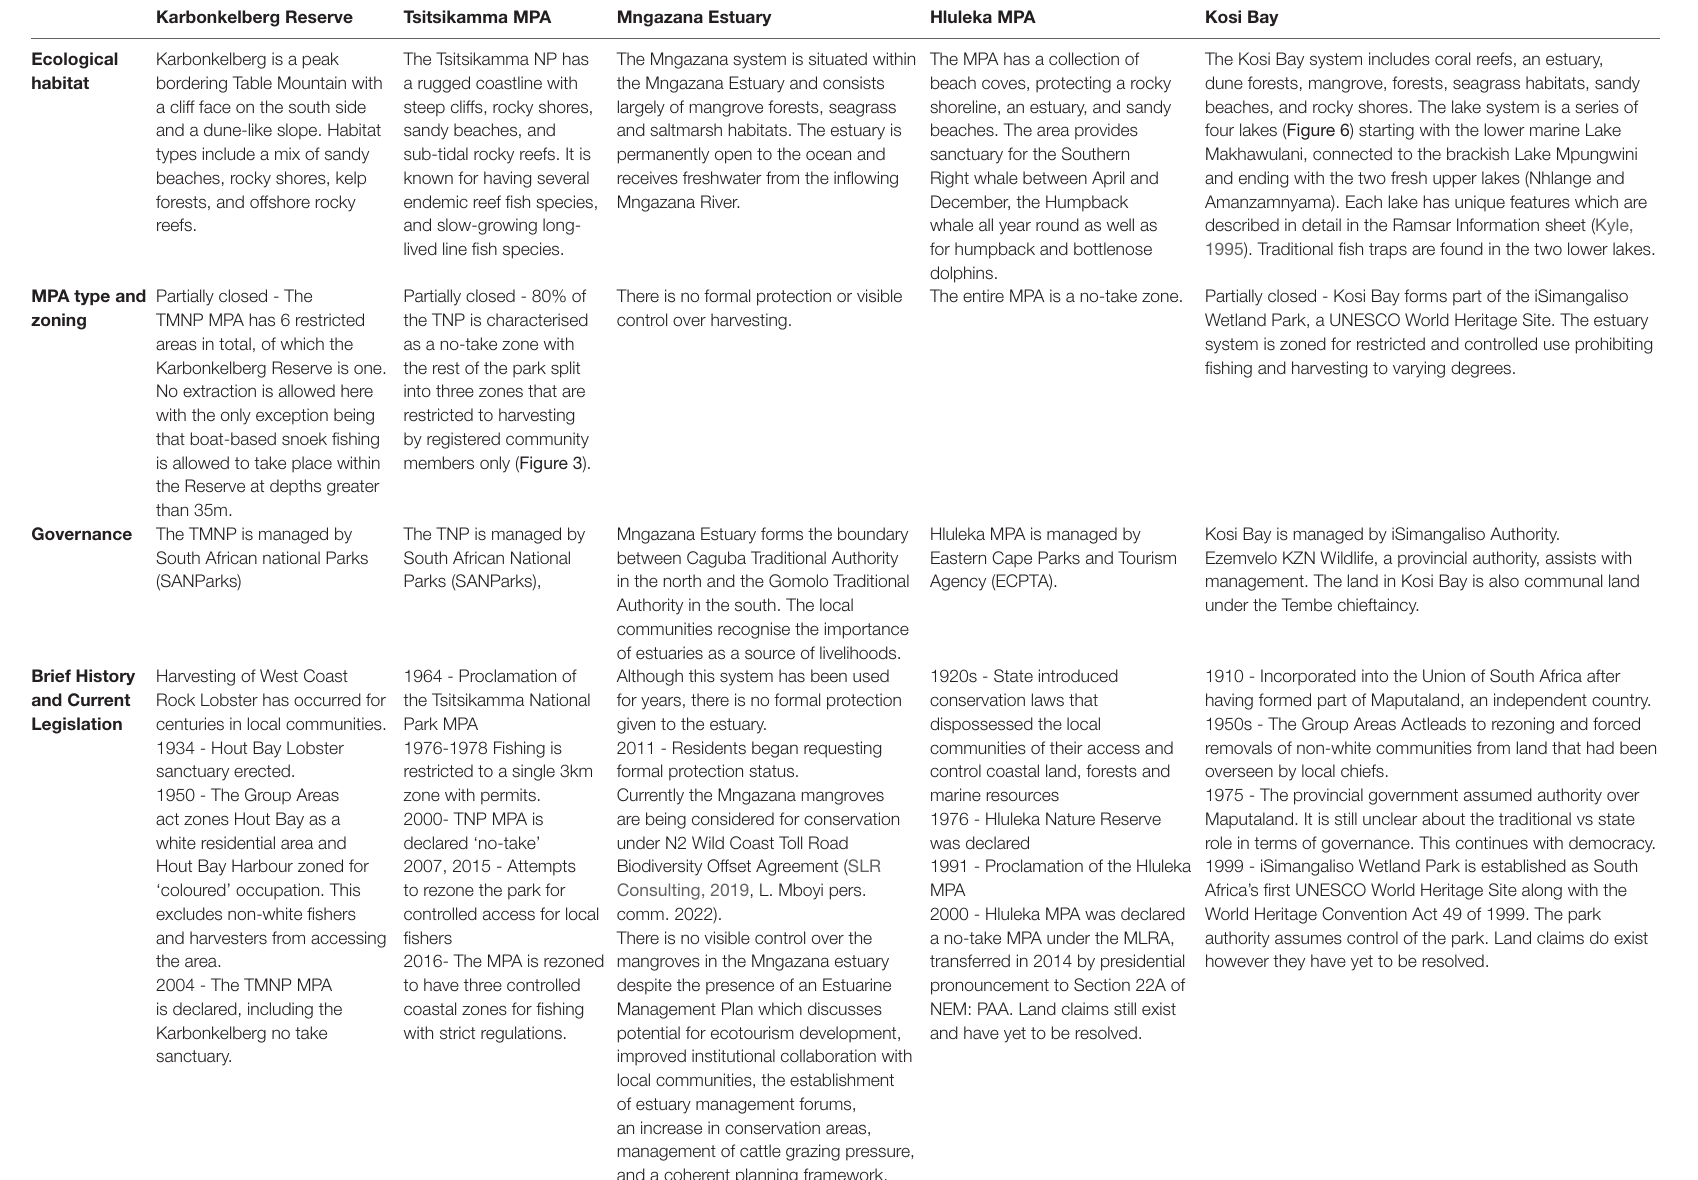
TABLE 1 | An overview of the five case studies highlighting their location, ecology, history, current zonation, and challenges to allow for comparison across